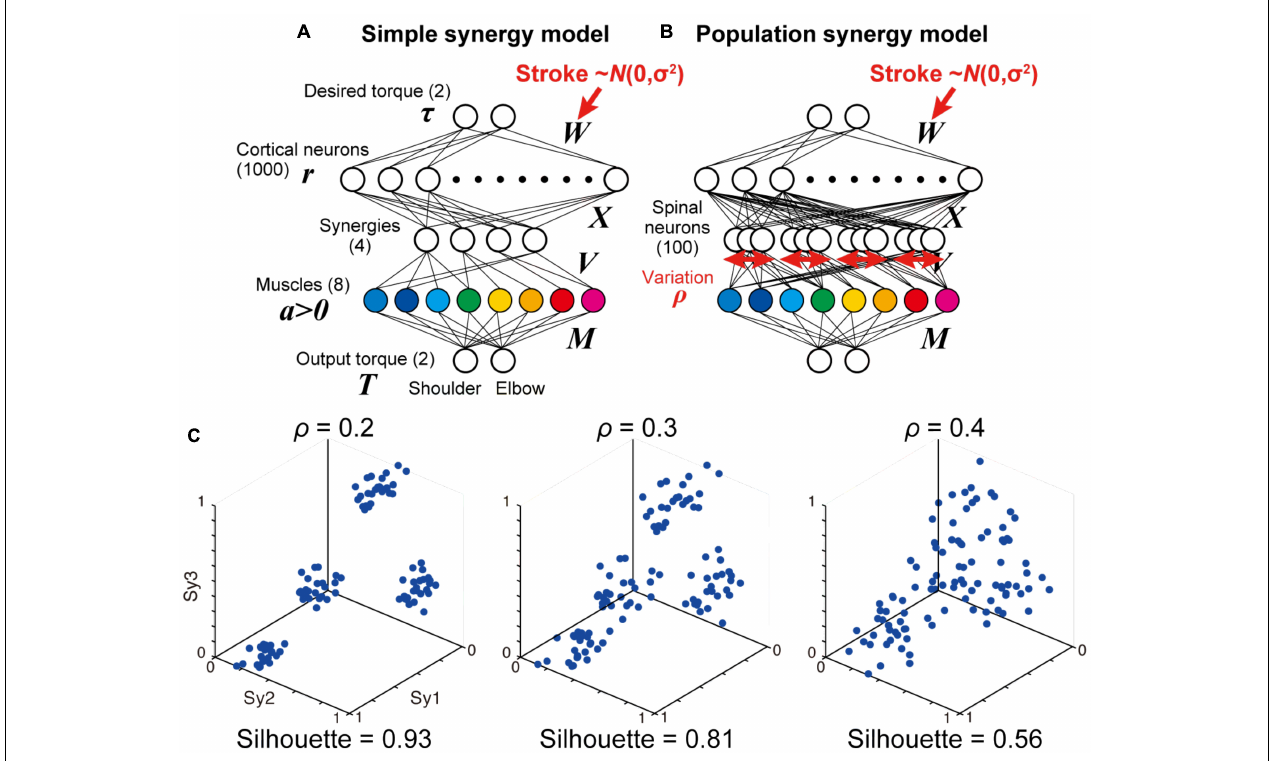
FIGURE 6 | Simple and population models for muscle synergies. (A,B) Neural network models with simple synergies (A , same as Figure 1B) and population synergies with some variations (B) . (C) Spatial similarity of output weights of each synergy ( V ) with the original muscle synergies with different spinal variation levels ( ρ = 0.2, 0.3,